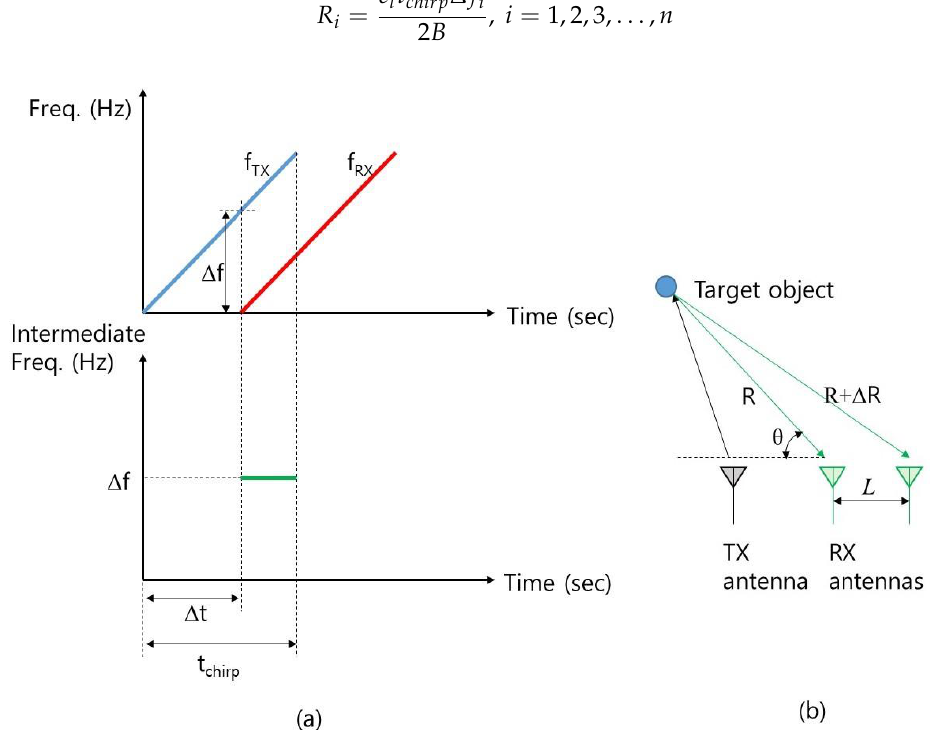
Figure 7. ( a ) Basic operation of the FMCW radar system, ( b ) Two RX antennas configuration for estimating AoA.